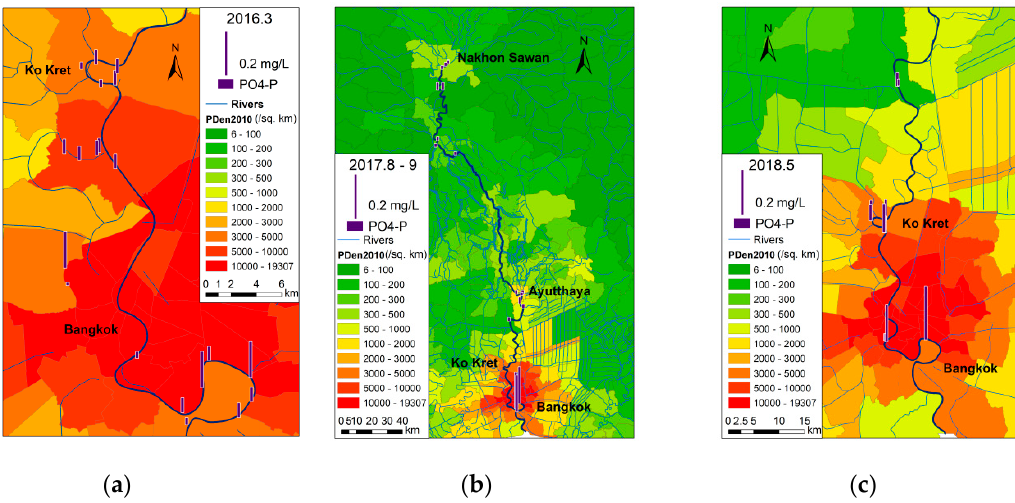
Figure 6. The spatial–temporal variation of PO 4 -P. ( a ) Dry; ( b ) Beginning; ( c ) Second half.